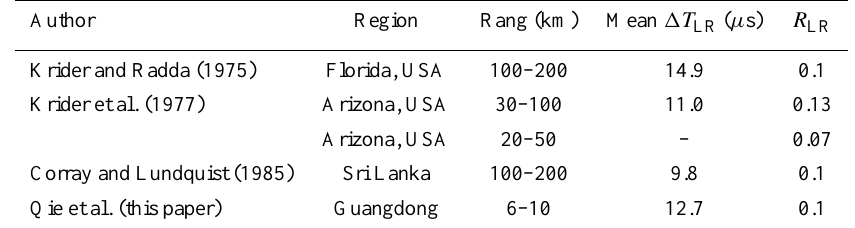
Fig. 2. Histogram of the time interval between the peak of the last leader pulse and the following first return stroke peak. Table 1. Time interval 1T LR and ratio R LR between the last stepped leader pulse peak to the following first return stroke